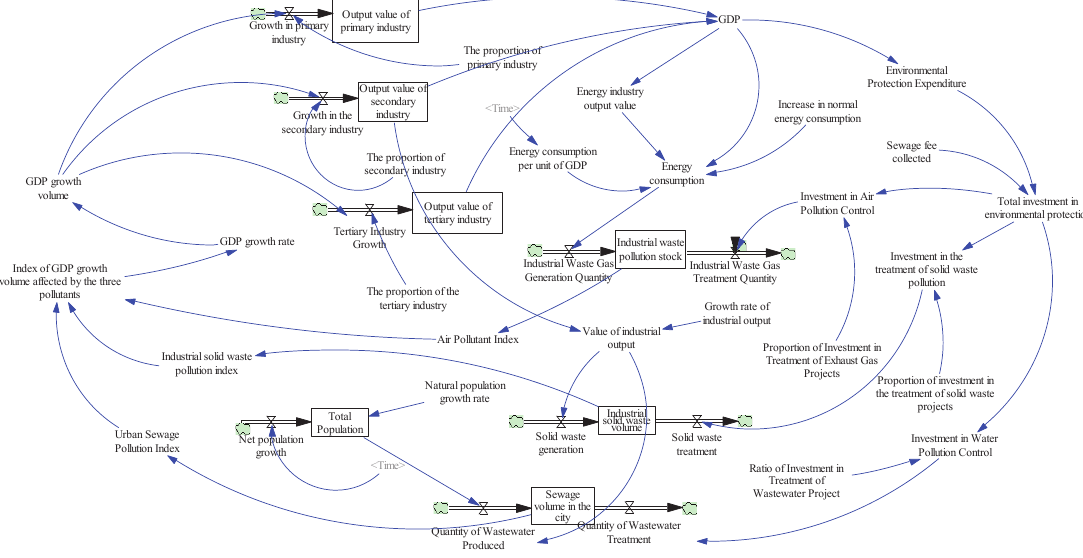
Fig. 3 3E system inventory and flow